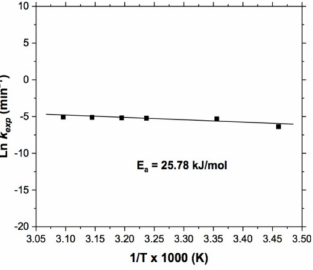
Figure 8. Copper leaching: effect of stirring rate.